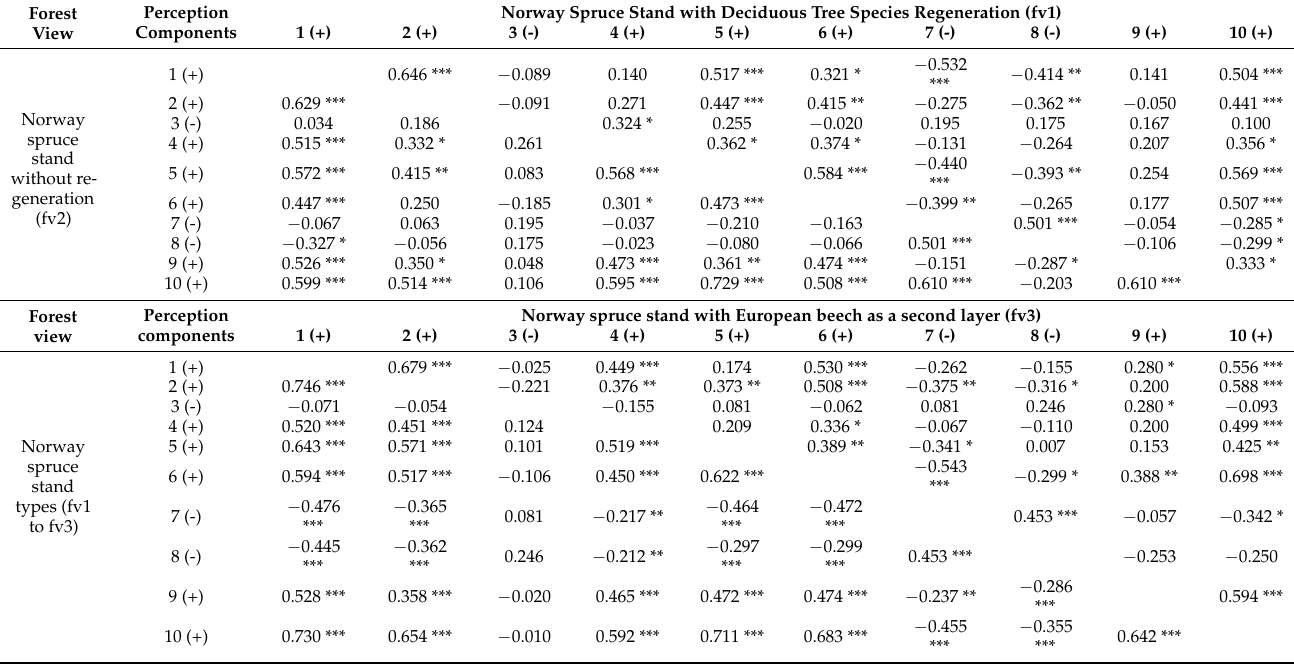
Table 3. Results of Spearman rank correlations for all three forest stand types (coefficients, p -values: *** ≤ 0.001, ** ≤ 0.01, * ≤ 0.05) and summarised. (The numbers represent the following perception components: 1—aesthetic effects, 2, 3—visual diversity, 4—comprehensibility, 5—ecological aesthetics, 6, 7—restfulness, 8, 9—spatial arrangement, 10—acceptance. The additional symbol next to the statement number marks the type of formulation: + positive, -